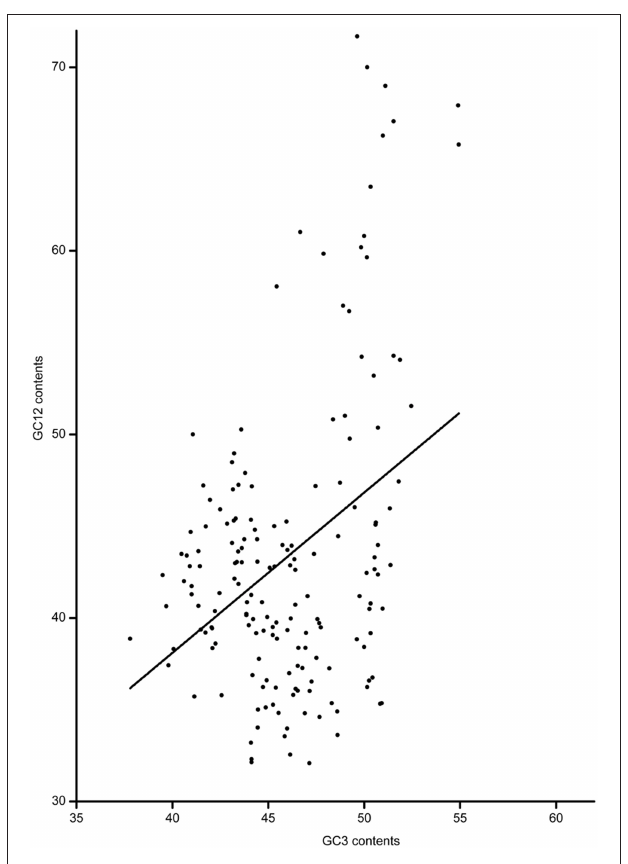
FIGURE 3 | Relationship between gene expression and CDS length. The regression line: y = − 0.000000762534 X +